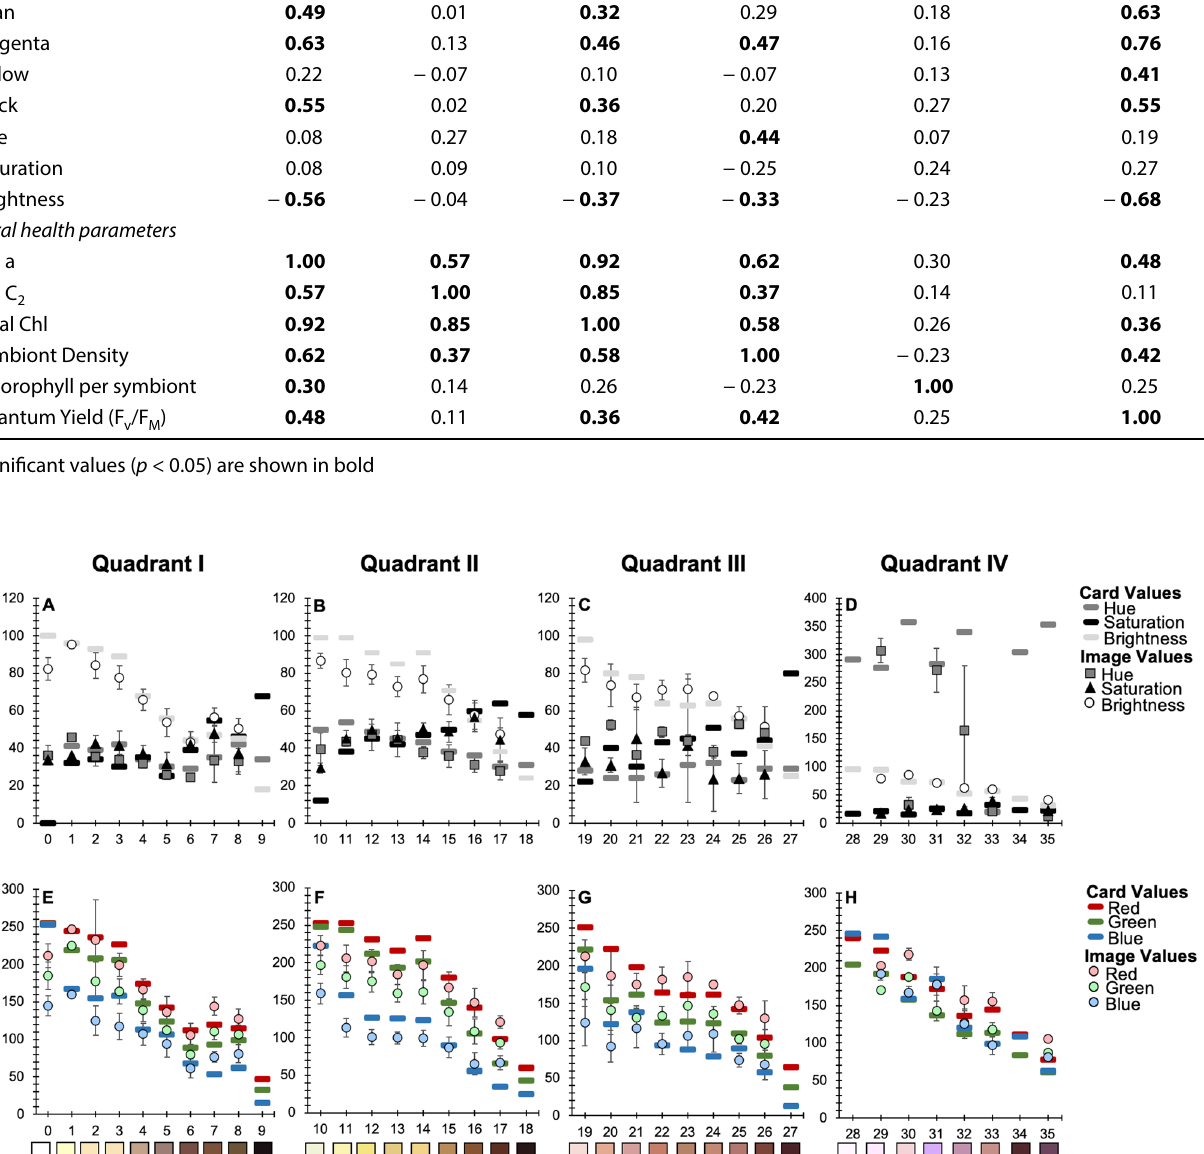
grey square; saturation black triangle; brightness, white circle) and RGB channels (red, red circle; blue, blue circle; green, green circle). Mean color scale image values are pooled across species within each Hawaiian Ko ʻ a Card Number and error bars represent SD of the